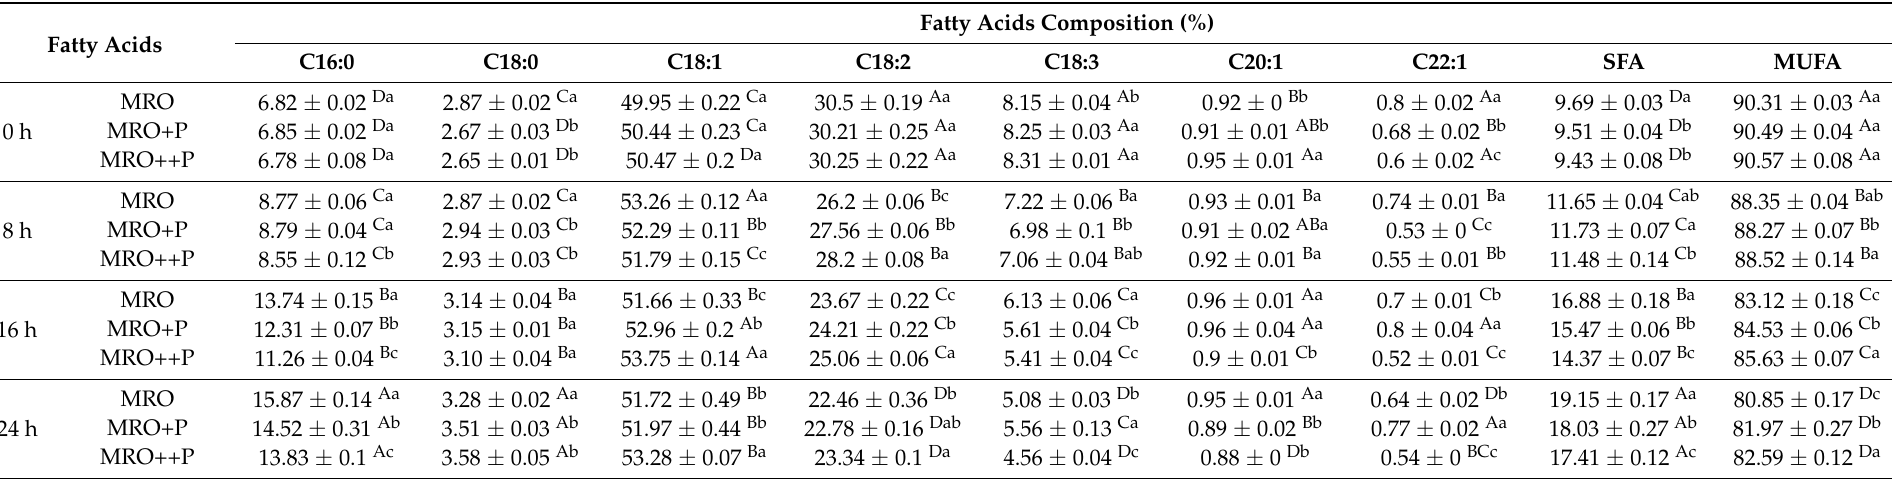
Table 2. The fatty acid composition of oil during